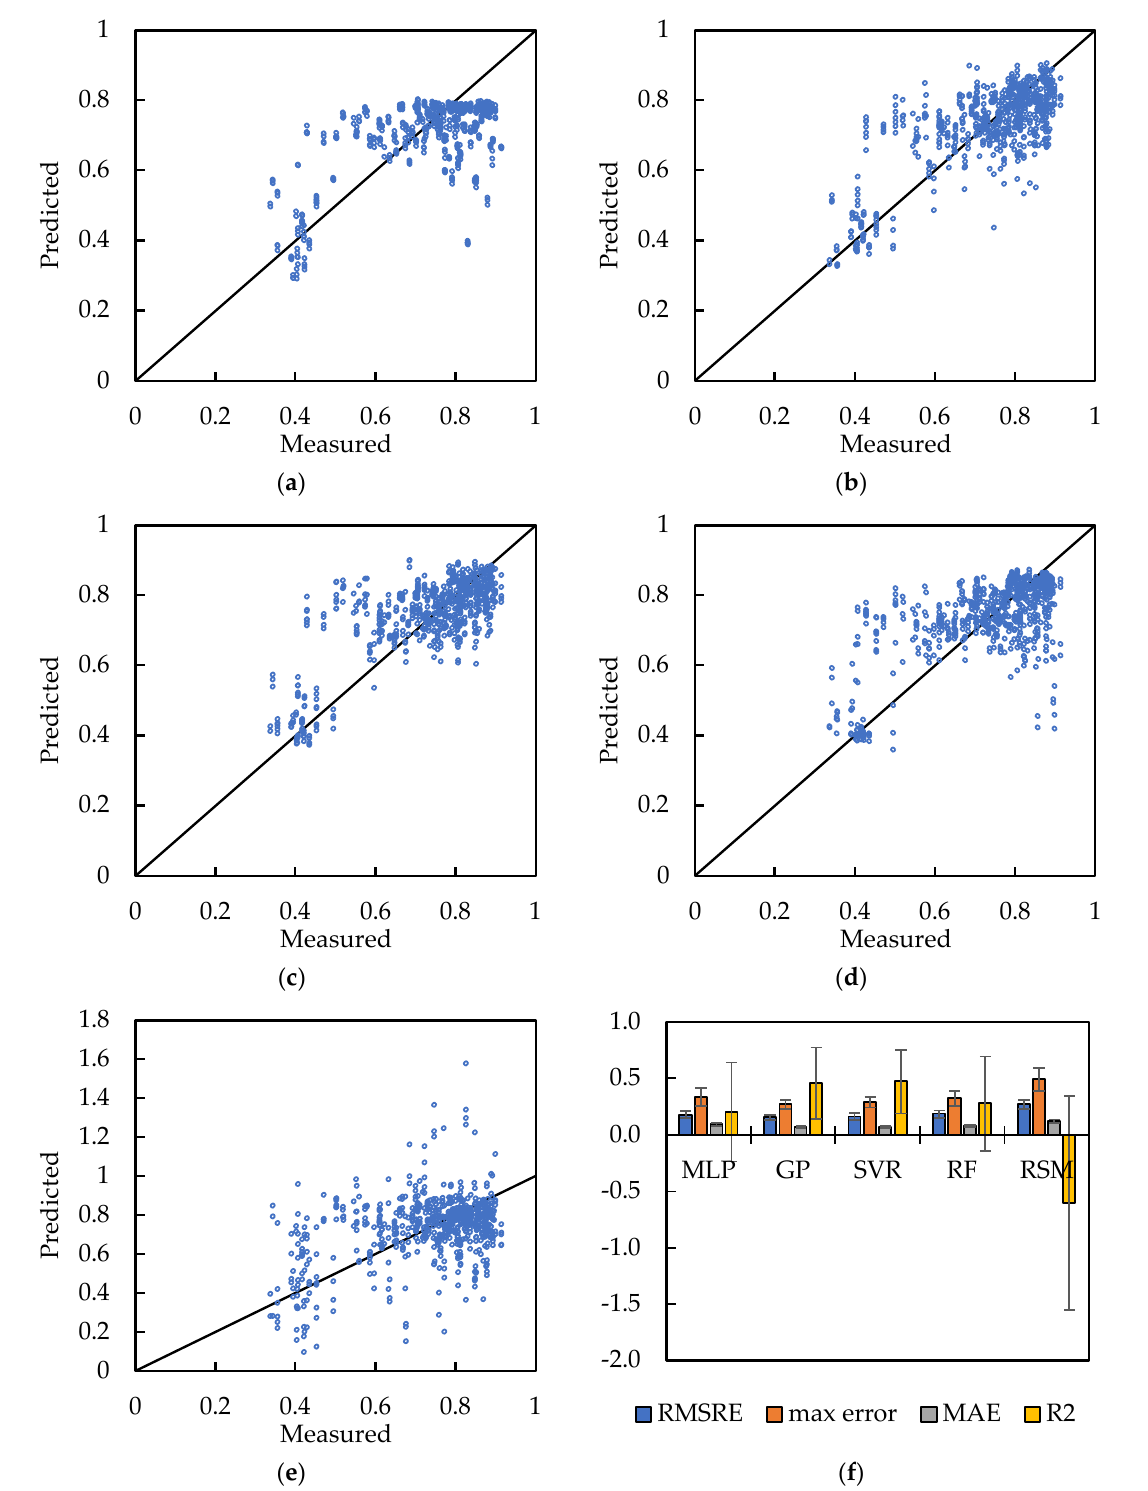
Figure 5. Prediction of fracture strain in the HET as a function of the respective measured value, for all 15 cases analysed: ( a ) MLP; ( b ) GP; ( c ) SVR; ( d ) RF; ( e ) 2nd order polynomial fitting; ( f ) performance metrics (see also Table 4).